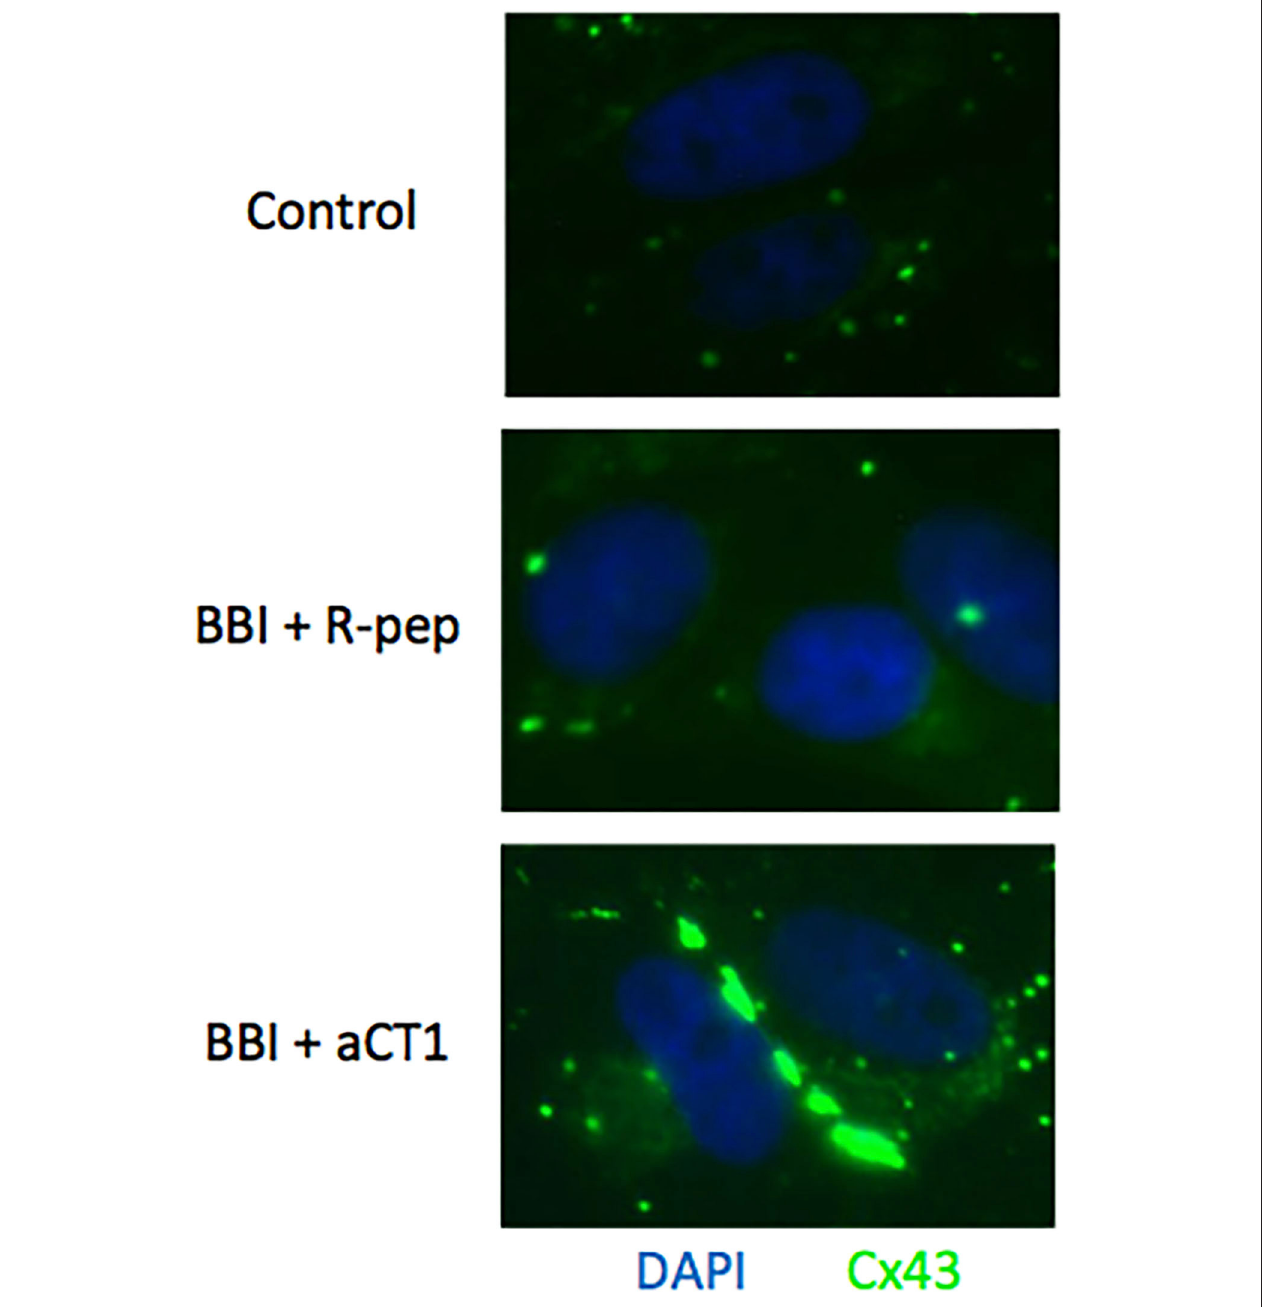
FIGURE 5 | Cx43 expression after BBI and aCT1 peptide treatment in TLM1 cells. Cx43 plaques seen as green dots in the membrane of TLM1 cells submitted to treatment with 400 µ g/ml BBI and 200 µ M aCT1 peptide (or R-pep) for 3 days.